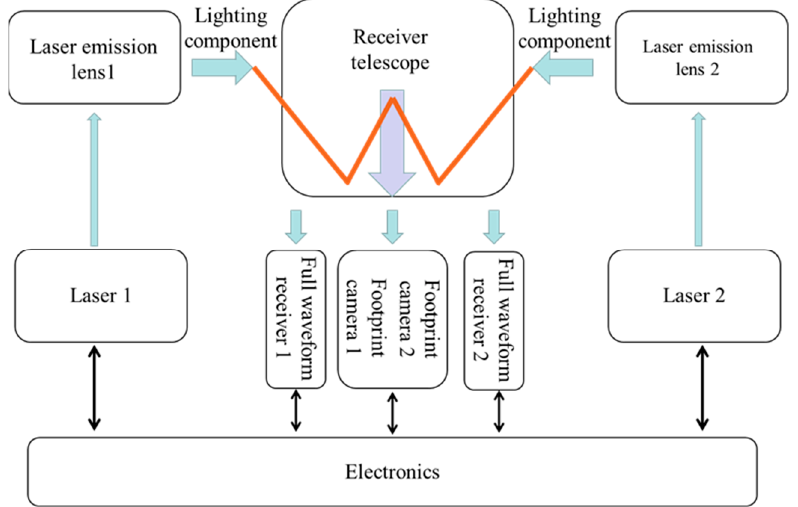
Figure 1. Structural diagram of the GF-7 laser altimeter